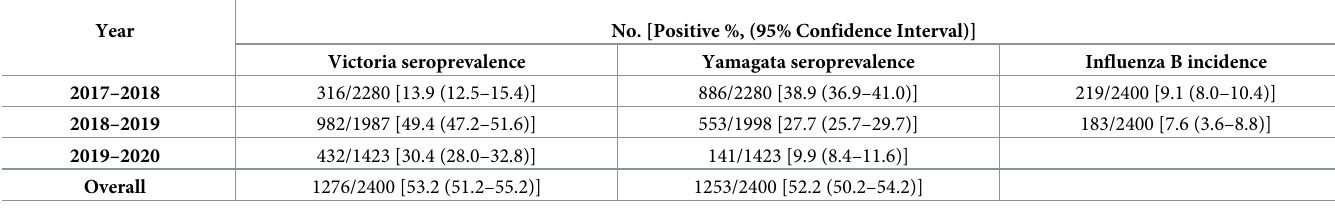
Table 2. Incidence and seroprevalence of Influenza B among study participants � , 2017–2019 in